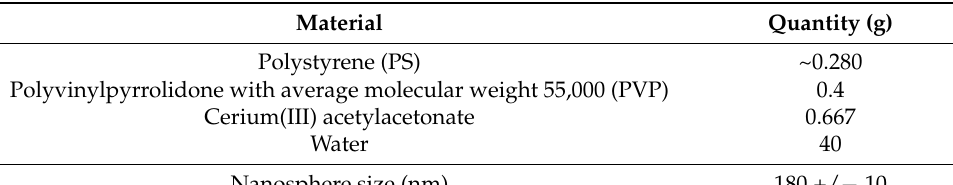
Table 2. The conditions used for the manufacture of coated polystyrene nanospheres. The size determined by TEM.